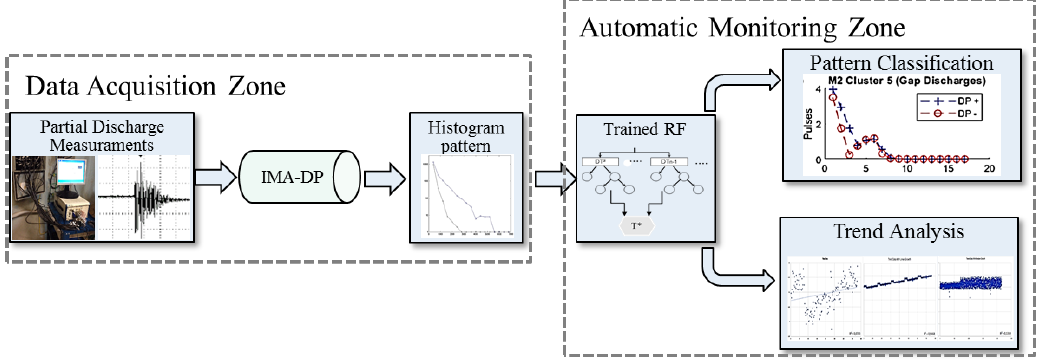
Figure 10. Flowchart representing the steps of online application.